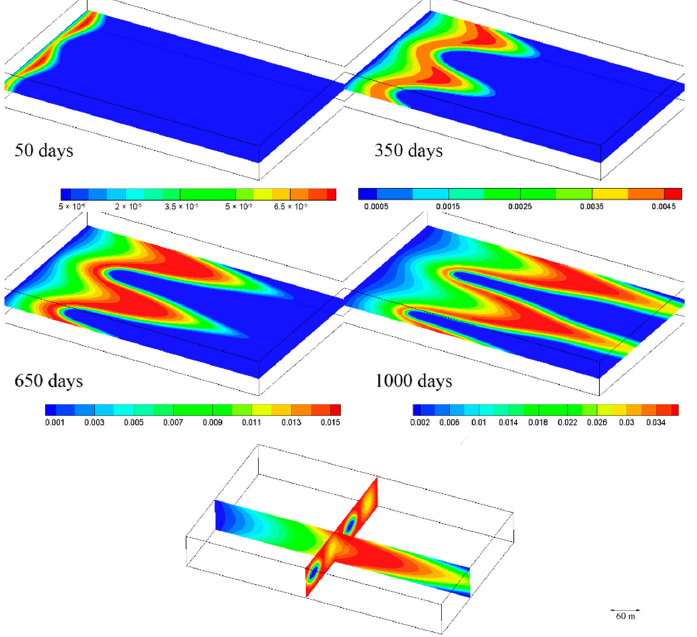
Figure 4. Z -axis slice depicting the change in solid mineral concentration over 1000 simulated days (i.e., about less than 3 years) with varying legend (in percent) to show small concentration at initial stage. Further simulation has been conducted on a domain with filtration properties distri- bution taken from a real deposit in Southern Kazakhstan (Figure 5) to generate a second deposit.